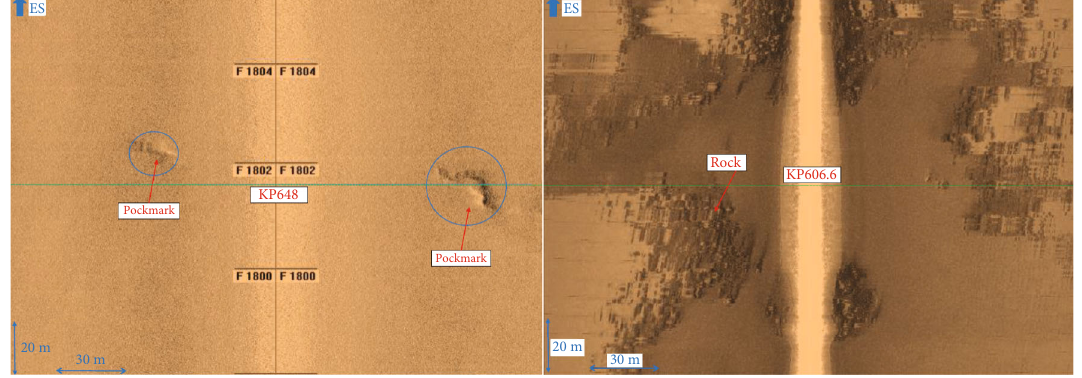
Figure 18: Typical land slope side-scan sonar image (the left is a group of pockmarks, and the right is exposed rock in the submarine trench area).